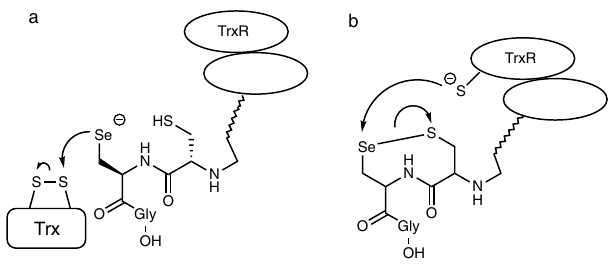
Fig. 1 Schematic role of selenium in the TrxR-proposed mechanisms.